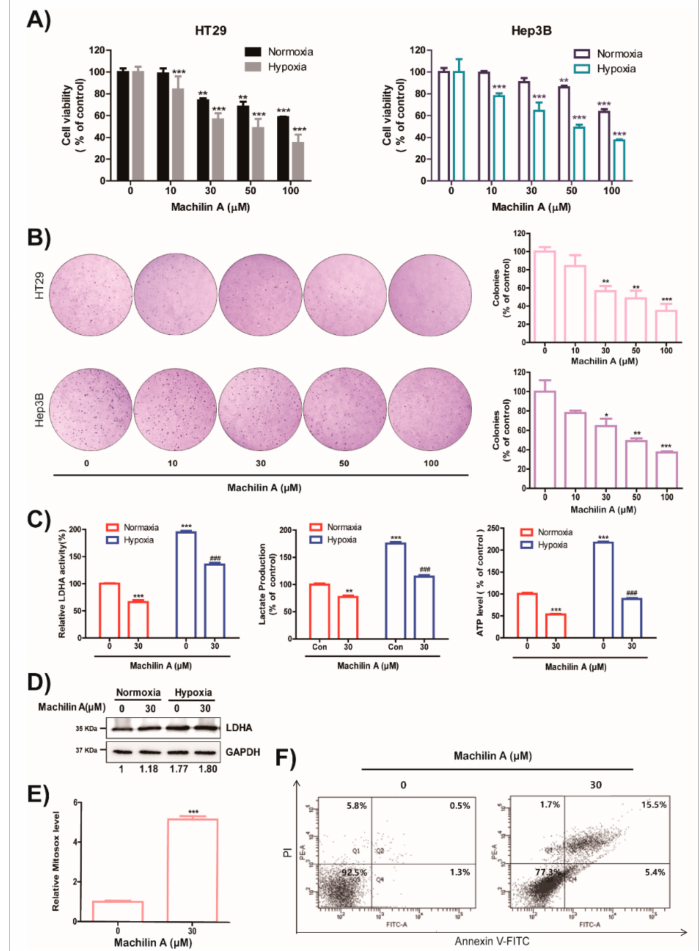
Figure 3. E ff ect of machilin A on cell growth, colony formation, Lactate dehydrogenase A (LDHA) activity, lactate production, intracellular adenosine triphosphate (ATP levels), and expression of LDHA in cancer cells. ( A ) Cancer cells were treated with the indicated concentrations of machilin A for 48 h under hypoxia. The viabilities of cells were evaluated using an MTT assay. Results of three independent replicates are shown as means ± SD. Statistic tests were performed using a one-way analysis of variance (ANOVA). *** p < 0.001 compared to the control. ( B ) To determine colony formation capacity of cancer cells, HT29 colon cancer and Hep3B liver cancer cells were treated with machilin A for three weeks, and colonies were counted. Results are presented as means ± SD. Statistic tests were performed using a one-way analysis of variance (ANOVA). * p < 0.05, ** p < 0.01, and *** p < 0.001, compared to the control. ( C ) HT29 colorectal cancer cells were treated with machilin A (30 µ M) under normoxic and hypoxic conditions. Potential inhibition of LDH activity was assessed using HT29 cell lysates. Production of lactate was measured using a commercially available L-lactate assay kit. Results of three independent replicates are shown as means ± SD. Statistic tests were performed using a Student’s t-test. ** p < 0.01 and *** p < 0.001, compared to the control under normoxia (first column). ### p < 0.001 compared to control under hypoxia (third column). ( D ) Expressions of LDHA were analyzed using a western blot assay. GAPDH expression was used as an internal control. ( E ) The HT29 cells were treated with machilin A for 24 h. The production of intracellular reactive oxygen species (ROS) was detected by Fluorescence-activated cell sorting (FACS) analysis using mitochondrial ROS indicator, Mitosox. Results of three independent replicates are shown as means ± SD. Statistic tests were performed using a Student’s t-test. *** p < 0.001, compared to the control (first column). ( F ) The HT29 cells were treated with indicated concentrations of machilin A for 48 h. The cells were harvested, stained with Annexin V / PI, and analyzed by flow